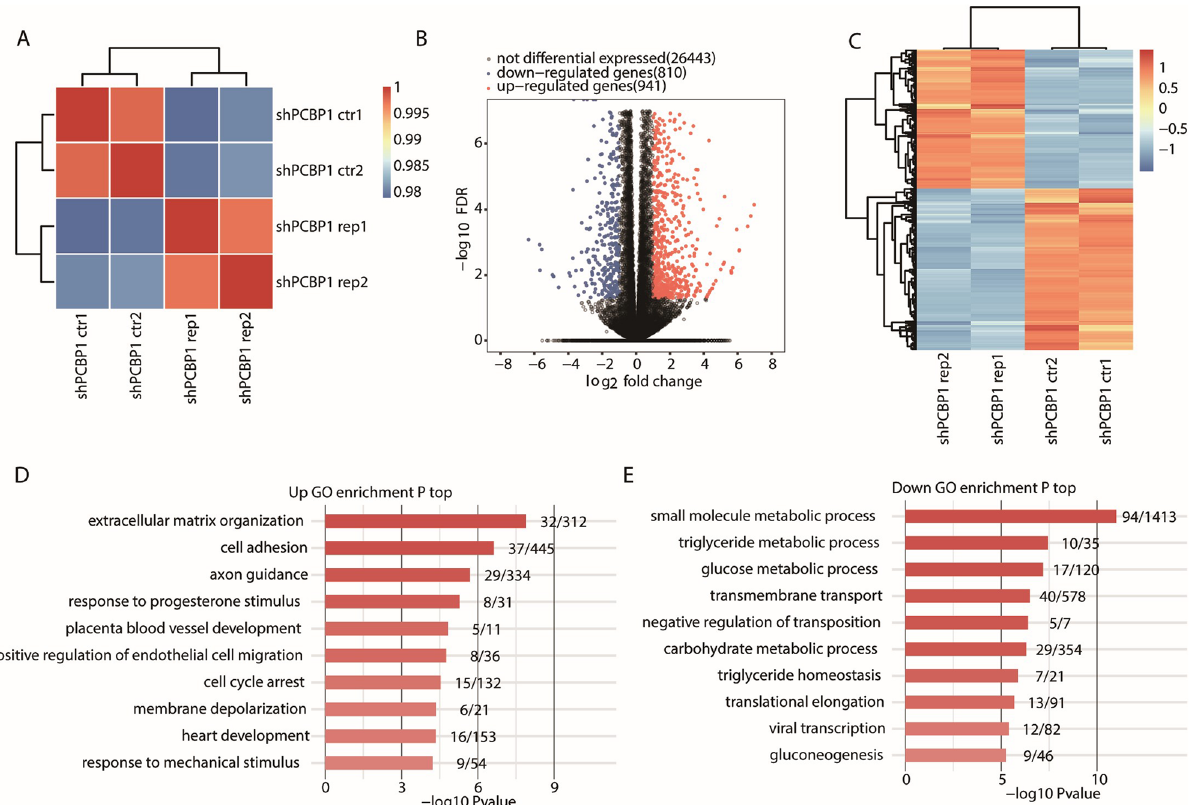
Figure 1. Transcriptome-wide analysis revealed abnormal gene expression after knockdown PCBP1 in HepG2 cells. ( A ) Hierarchical clustering heat map showing correlation between PCBP1-knockdown (shPCBP1 rep1/2) and control (shPCBP1 ctr1/2) samples based on FPKM value of all expression genes. ( B ) Volcano plot showing all differential expressed genes (DEGs) between PCBP1-knockdown and control samples using DESeq2. FDR ≤ 0.05 and FC (fold change) ≥ 2 or ≤ 0.5. ( C ) Heatmap showing expression profile of all significant DEGs between PCBP1-knockdown and control samples. ( D ) Bar plot showing the top10 most enriched GO biological process terms of the up-regulated DEGs. ( E ) Bar plot showing the top10 most enriched GO biological process terms of the downregulated DEGs. PCBP1, Poly C Binding Protein 1; FPKM, fragments per kilobase of exon per million; DEGs, differentially expressed genes; FDR, false discovery rate; FC, fold